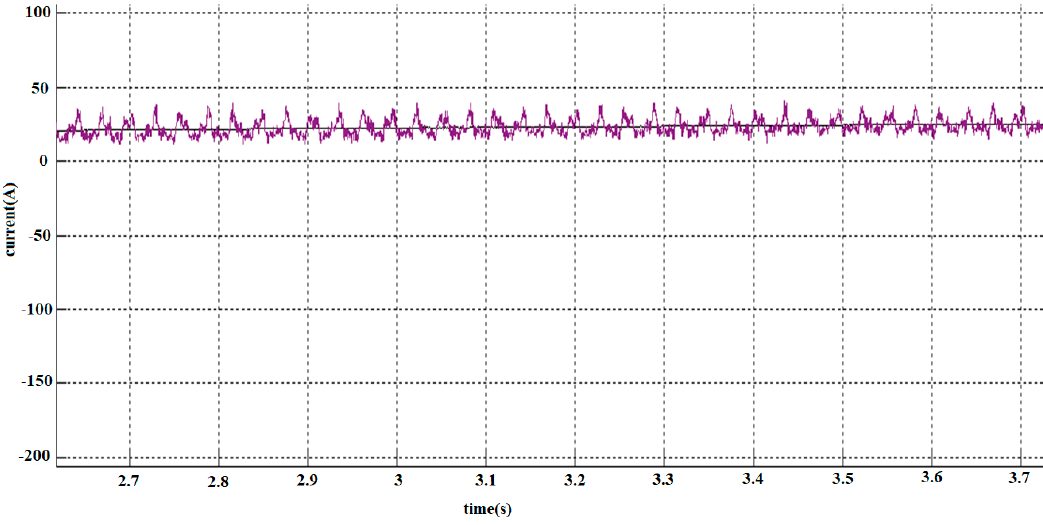
Figure 16. Input-side current tracking of q axis.